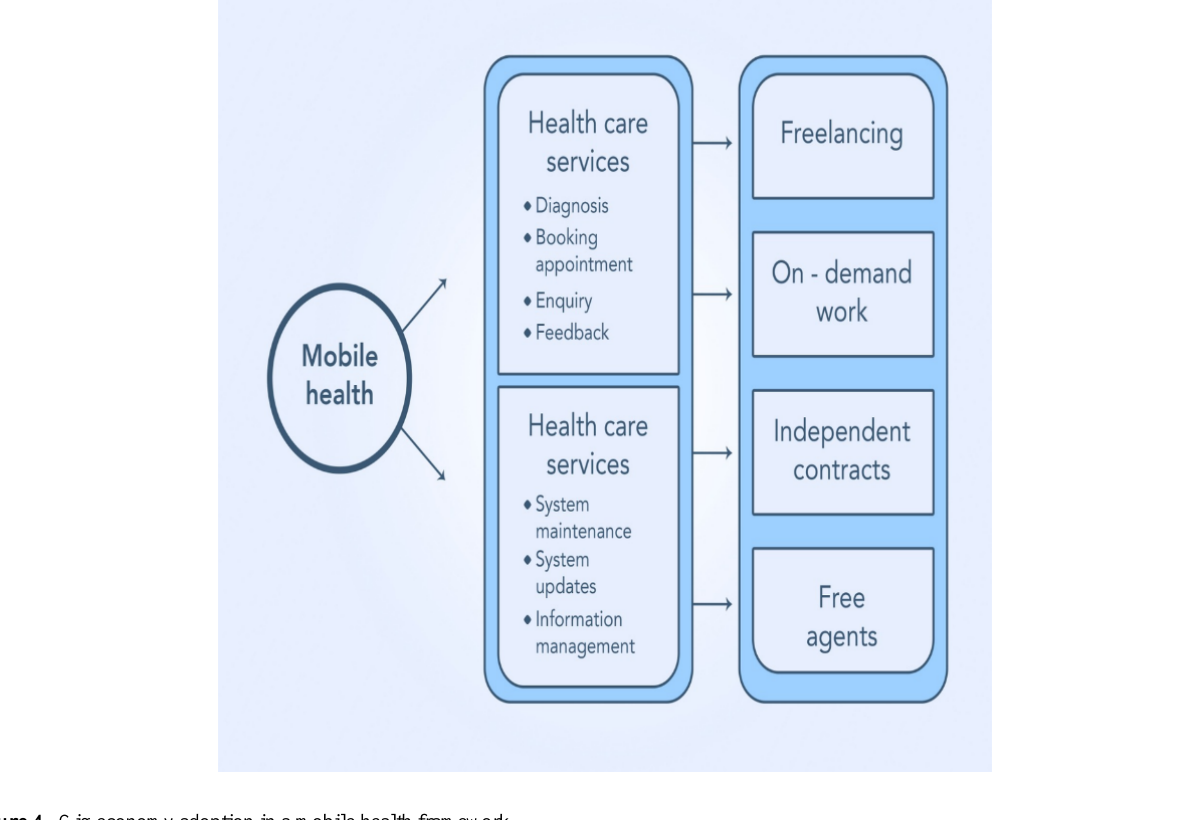
Figure 3. General gig mobile health system.